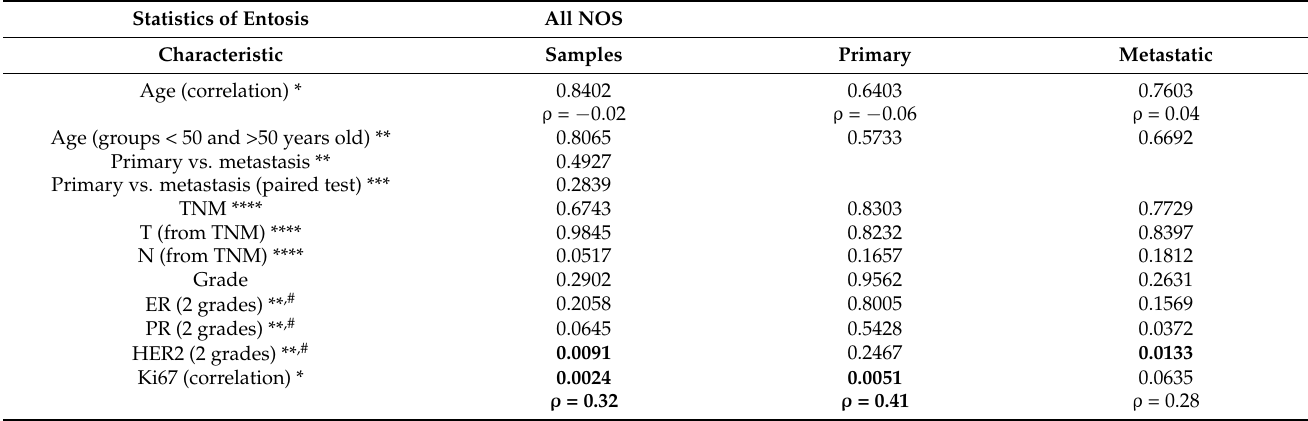
Table 2. Statistical analysis between the number of entoses and selected parameters in the cohort of breast cancer patients ( p -values) ( ρ —Spearman’s correlation coefficients).